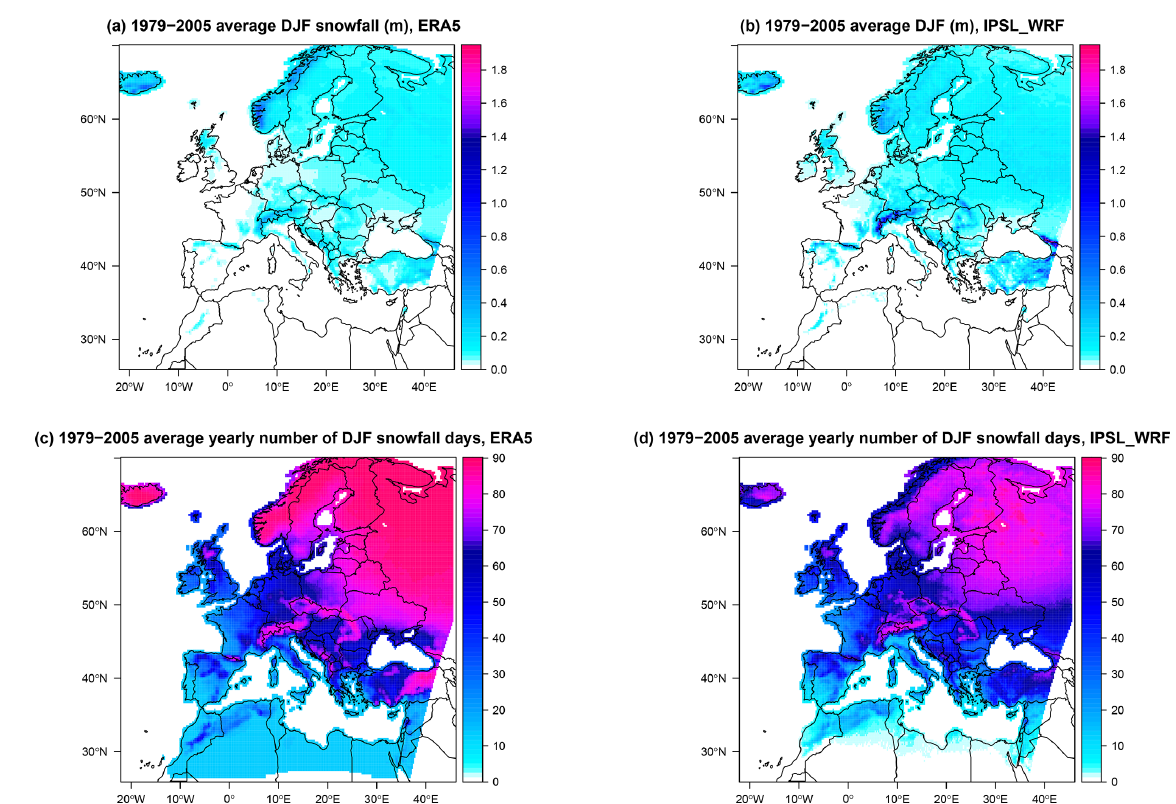
Figure 1. The (a, b) 1979–2005 average DJF snowfall (m) and (c, d) 1979–2005 number of DJF snowfall days. The left column shows ERA5, and the right column shows